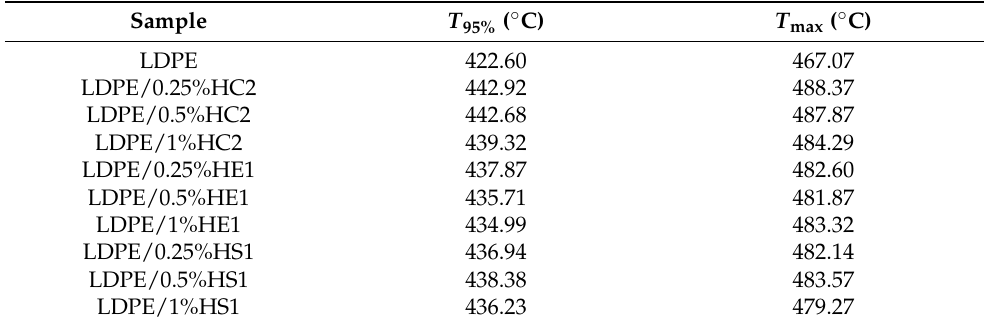
Table 2. Initial decomposition temperature of the samples ( T 95% ) and the temperature of the maxi- mum rate of decomposition ( T max